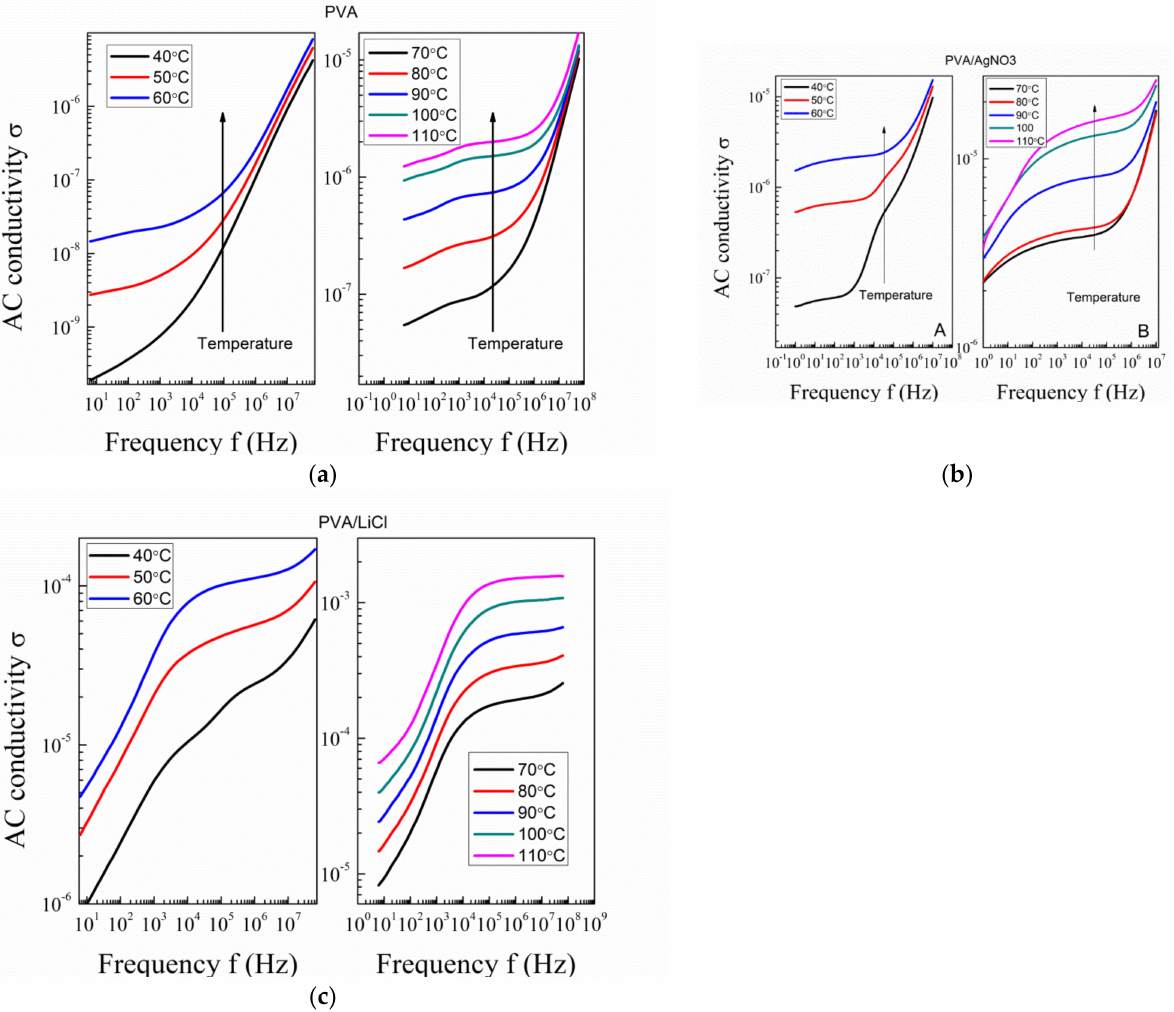
Figure 3. ( a ) shows the ac conductivity of the S1 (PVA) film as a function of frequency, ( b ) shows the ac conductivity of the S2 (PVA/AgNO 3 ) film as a function of frequency and ( c ) shows the ac conductivity of the (S3) PVA/LiCl film as a function of